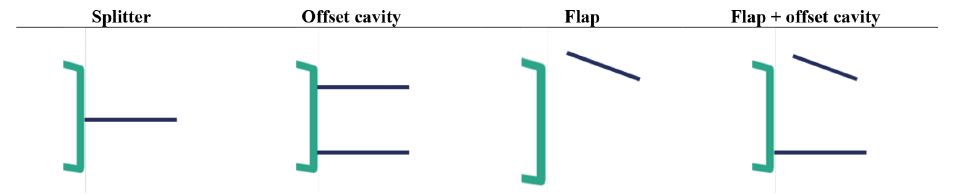
Figure 3. Close-up detail of the blunt trailing edge with the four devices considered in this study.